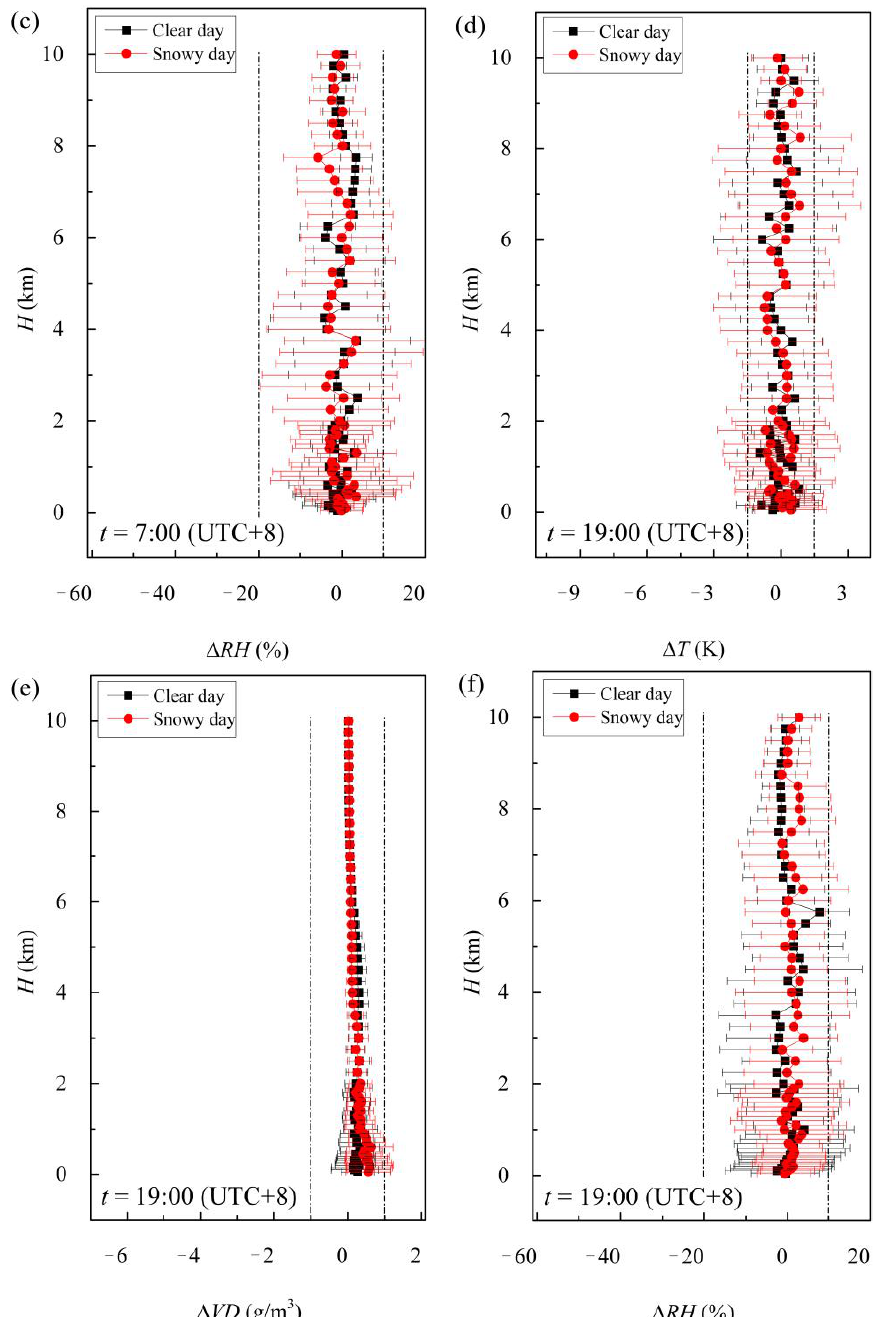
Figure 5. Comparison of temperature bias ( a , d ), vapour density bias ( b , e ), and relative humidity bias ( c , f ) profiles obtained from MWR and RAOB under clear-sky and snowy-sky conditions. RMSEs are marked by error bars.